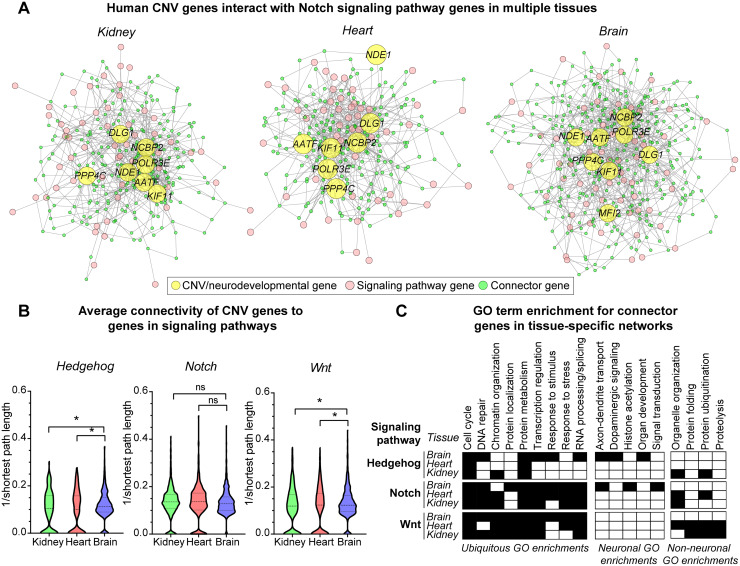
Connectivity of human CNV genes with conserved signaling pathway genes in human tissue-specific networks.(A) Network diagrams representing the connectivity of eight human CNV and neurodevelopmental genes whose fly homologs disrupt the Notch signaling pathway to 57 human Notch signaling genes within kidney, heart, and brain-specific gene interaction networks are shown. Yellow nodes represent CNV and neurodevelopmental genes, pink nodes represent Notch signaling pathway genes, and green nodes represent connector genes located within the shortest paths between CNV and Notch pathway genes. (B) Violin plots show the average connectivity (i.e. inverse of shortest path lengths) of human CNV genes to genes in the Hedgehog, Notch, and Wnt signaling pathways across three tissue-specific networks (n = 322–810 pairs of genes, *p < 0.05, two-tailed Welch’s t-test with Benjamini-Hochberg correction). (C) Table shows clusters of enriched Gene Ontology (GO) Biological Process terms for connector genes observed for each signaling pathway in the three tested tissue-specific networks, categorized by enrichments in ubiquitous, neuronal, and non-neuronal tissues (p<0.05, Fisher’s Exact test with Benjamini-Hochberg correction).